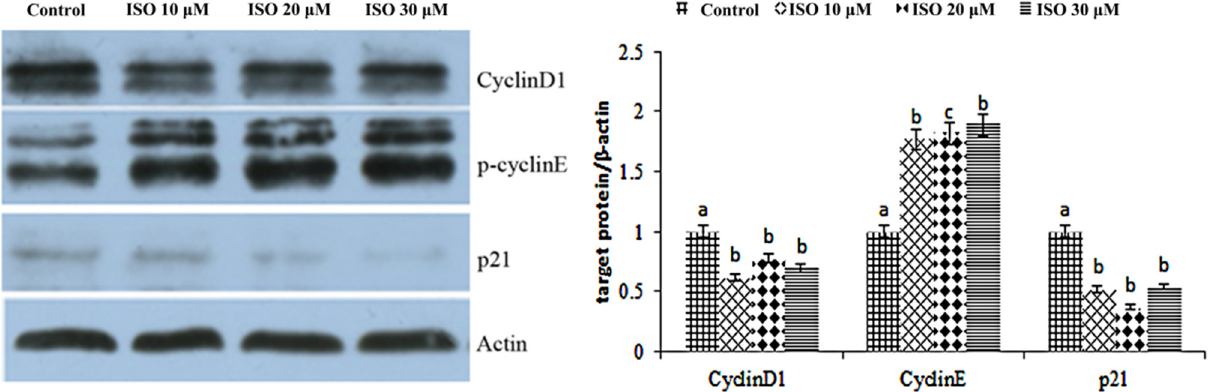
Figure 5. Effects of ISO on cyclins protein expression. Western blot was used to analyze cydin D1, cydin E, and p21 protein. Each value was mean ± SD ( n = 3). Different letters on the histogram indi- cate significant differences ( p < 0.5) in the mRNA expression of each group.